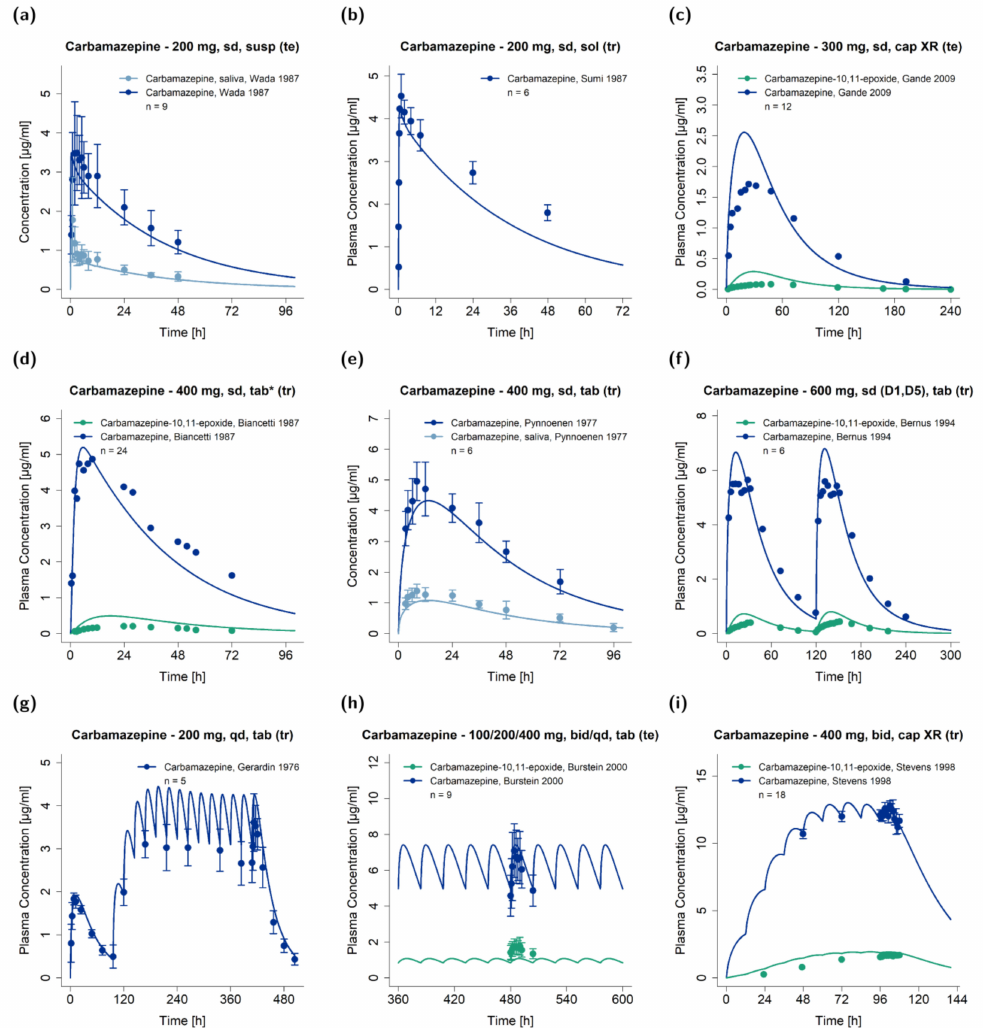
Figure 2. Model predictions of carbamazepine (dark blue: plasma, light blue: saliva) and carbamazepine-10,11-epoxide (green) concentration − time profiles of exemplary studies after ( a – e ) single- and ( f – i ) multiple-dose administration of different carbamazepine formulations [70–78] in comparison to observed data. Observed data are shown as dots ± SD (if available), simulations are shown as solid lines. Detailed information about the study protocols and model simulations of all clinical studies used to evaluate the carbamazepine model performance are provided in the Supplementary